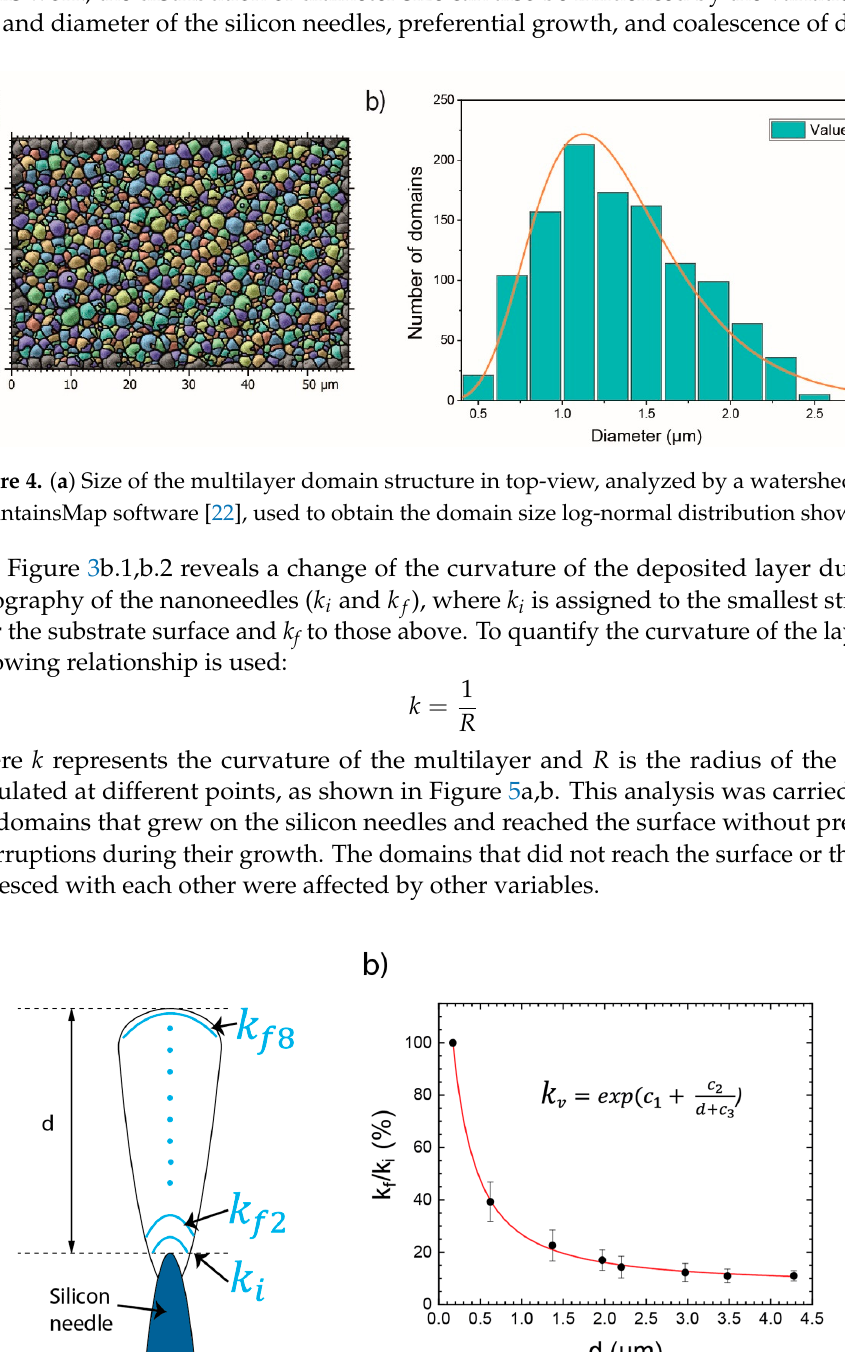
Table 1. Curvature measurements made at various distances 𝒅 from the tip of the needle in differ-